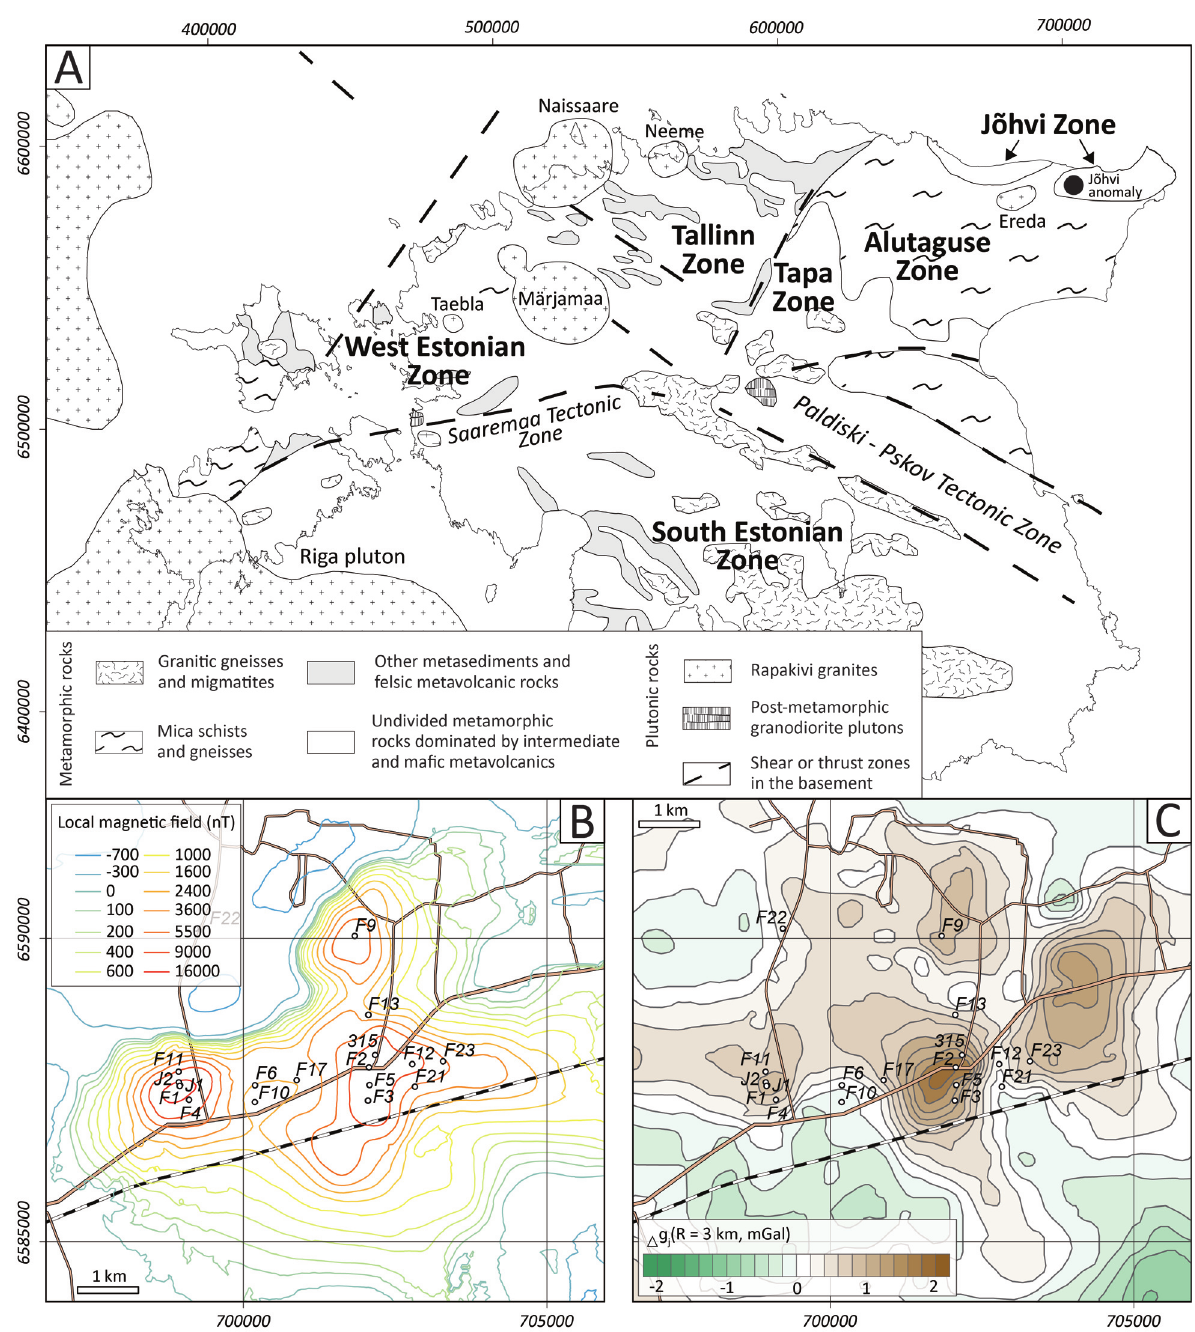
Fig. 1. The main geological outline of the Estonian Precambrian basement and the location of the Jõhvi Zone ( A ). Magnetic ( B ) and gravimetric ( C ) fields of the Jõhvi magnetic anomaly with location of historical drill